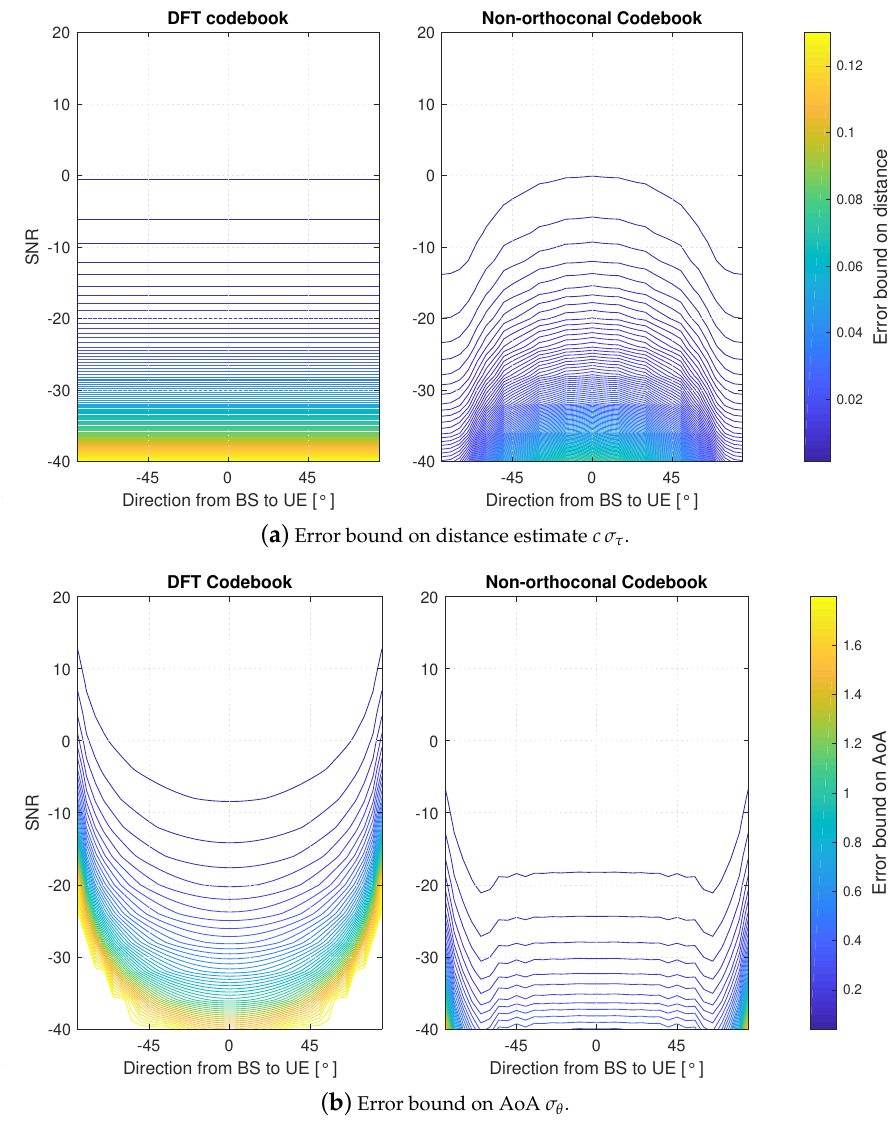
Figure 7. Error bounds on estimated mmWave channel